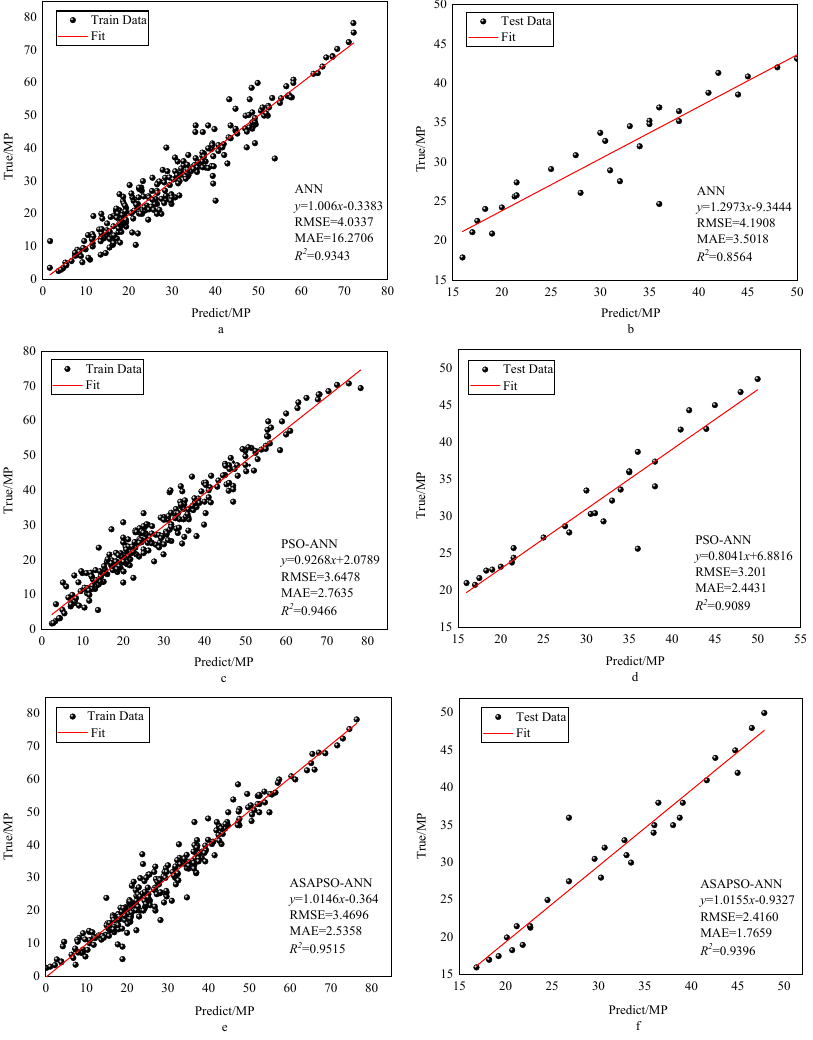
Figure 7. Regression analysis of the three models: ( a , b ) for the ANN model; ( c , d ) for the PSO-ANN model; ( e , f ) for ASAPSO-ANN model, for training and testing phases, respectively.